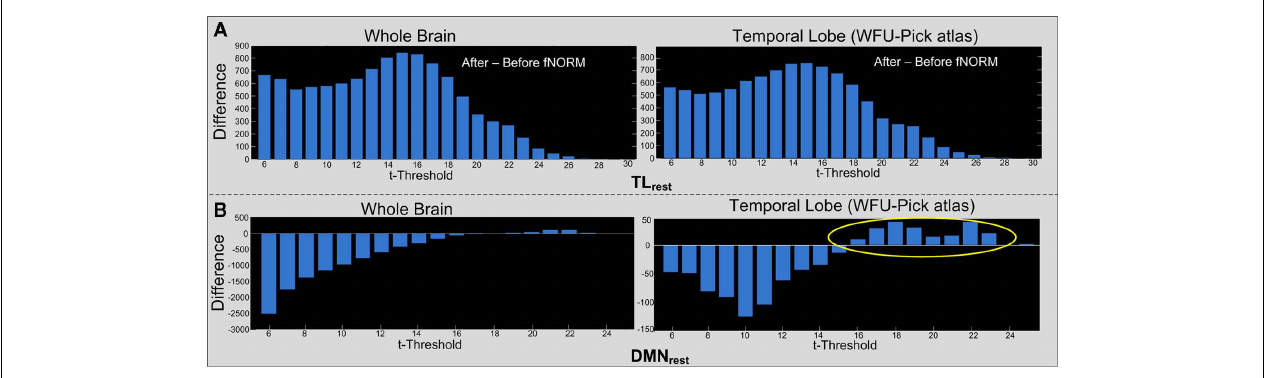
ICA-fNORM for increasing t -threshold ( x -axis). Differences are presented for Whole brain (left) andTemporal lobe ROI extracted usingWFU Pick Atlas (right) for each template: (A) TL rest and (B) DMN rest